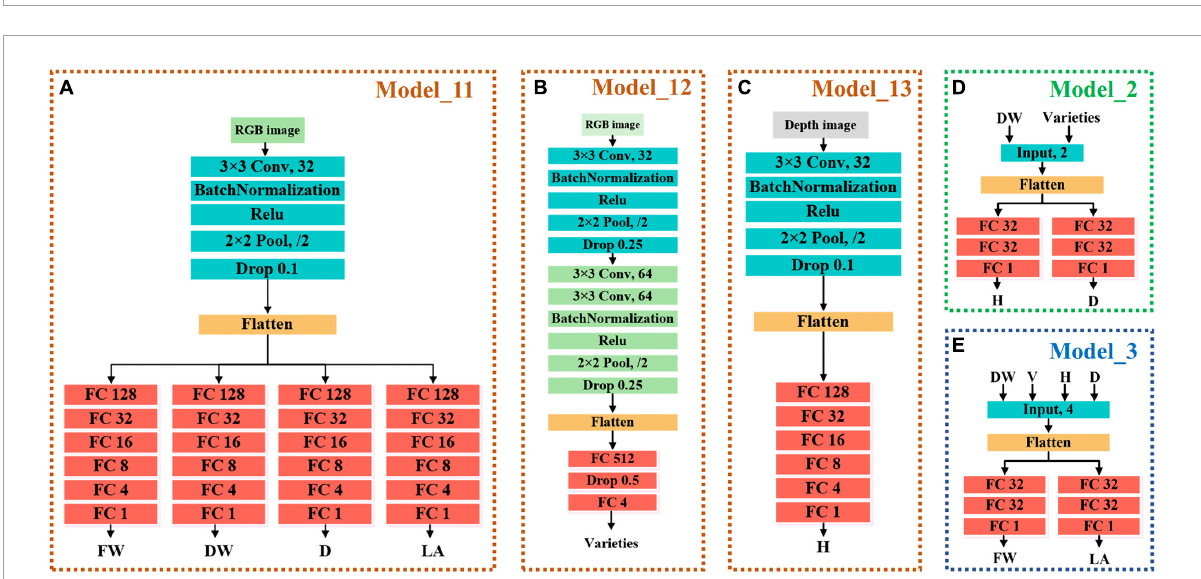
FIGURE5 Structure of each model. (A) Model_11 of the master models for estimating FW, DW, D, and LA. (B) Model_12 of the auxiliary models for predicting lettuce varieties. (C) Model_12 of the master models for estimating H. (D) Model_2 of self-correcting models of the auxiliary models for automatically adjusting H and D, which are located in the second stages of TMSCNet. (E) Model_3 of self-correcting models of the auxiliary models for automatically adjusting FW and LA, which are located in the third stages of TMSCNet.